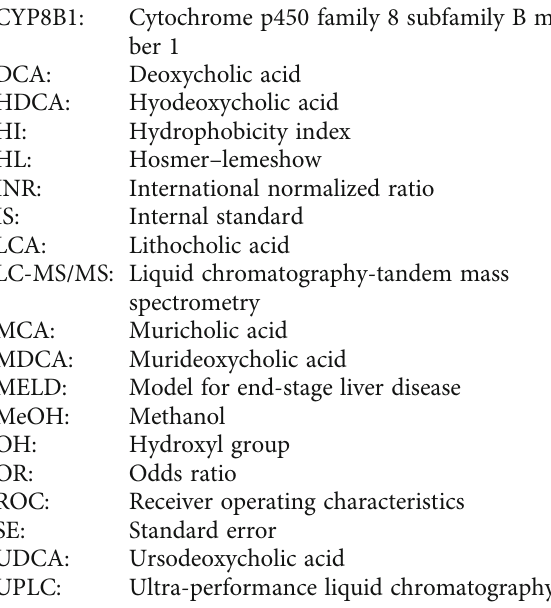
prediction of other liver disease complications using BALDC models. Supplementary Table S3: prediction of other liver disease complications using non-BA models. Supplementary Table S4: prediction of other liver disease complications using mixed BA and non-BA models. Supplementary Table S5: prediction of other liver disease complications using original MELD models. (Supplementary